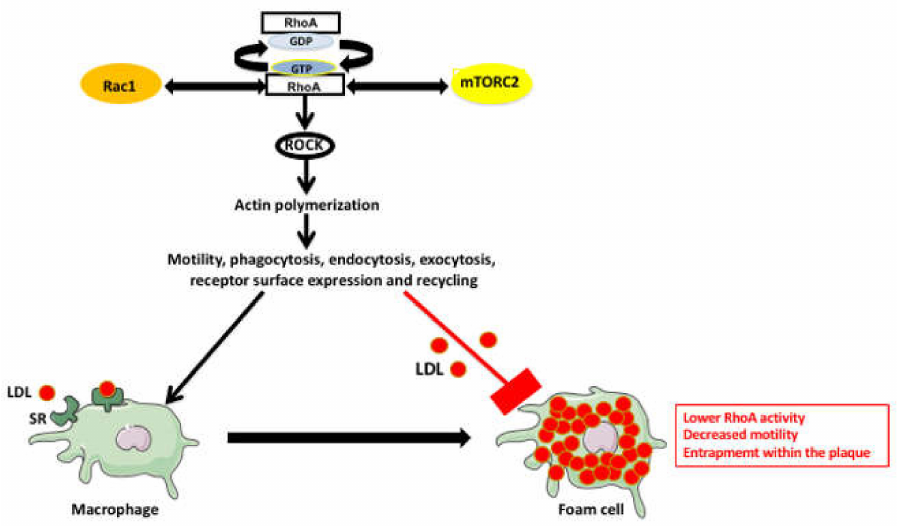
Figure 4. RhoA pathway involvement in macrophage and foam cell functions. The RhoA pathway controls, via ROCK kinase, the actin polymerization and actin-dependent functions in all cells including the macrophages. The RhoA pathway is reciprocally regulated by Rac1 and mTORC2 pathways. The macrophages uptake the LDLs through the SRs and become the foam cells. The foam cells have a lower activity of RhoA, which makes them less motile and leads to their entrapment within the atherosclerotic